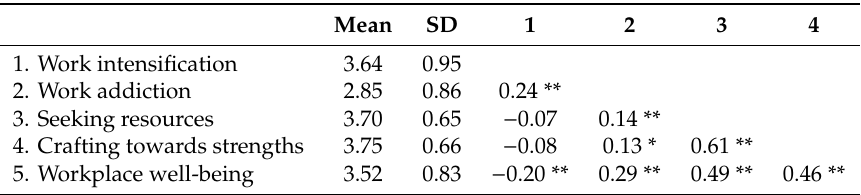
Table 2. Descriptive statistics and